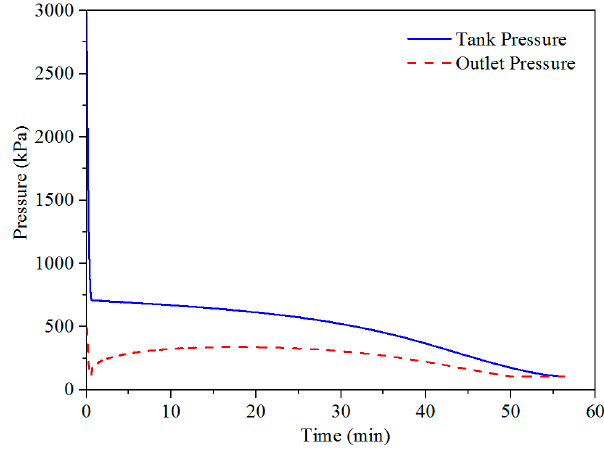
Figure 14. Changes in pressures in the tank and at the outlet of the leak hole over time.